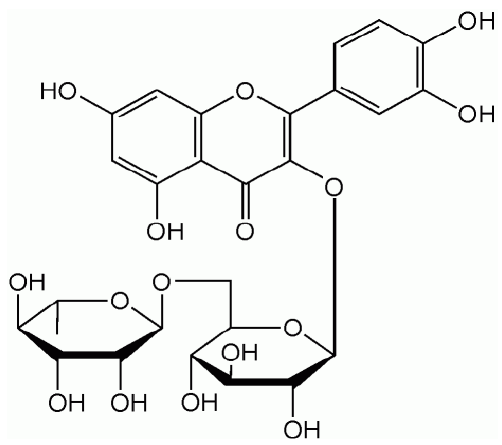
Figure 2. Conjugated quercetin (rutin)